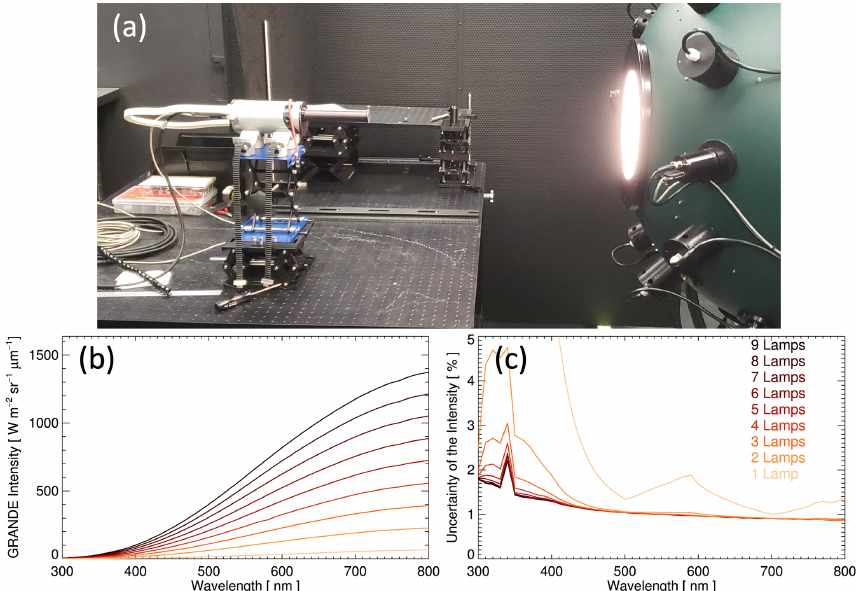
Figure 2. (a) Image of SMART–s calibration using the NIST-traceable light source (Grande) at the Radiometric Calibration Laboratory, NASA Goddard Space Flight Center. Panel (b) shows the spectral radiance of Grande in 300–800nm and (c) presents its reported uncertainty. Different colors in panels (b) and (c) indicate nine levels of the Grande radiance. The relatively higher values of uncertainty near 350nm in panel (c) are due to the filter change of the sensor during the light source